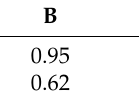
Figure 8. Scanning results of alloying elements: ( a ) Detection region; ( b ) Distribution of Al element; ( c ) Distribution of Zr element; ( d ) Distribution of B element. Table 1. Atomic ratios of elements in regions P1 and P2 (at.%).